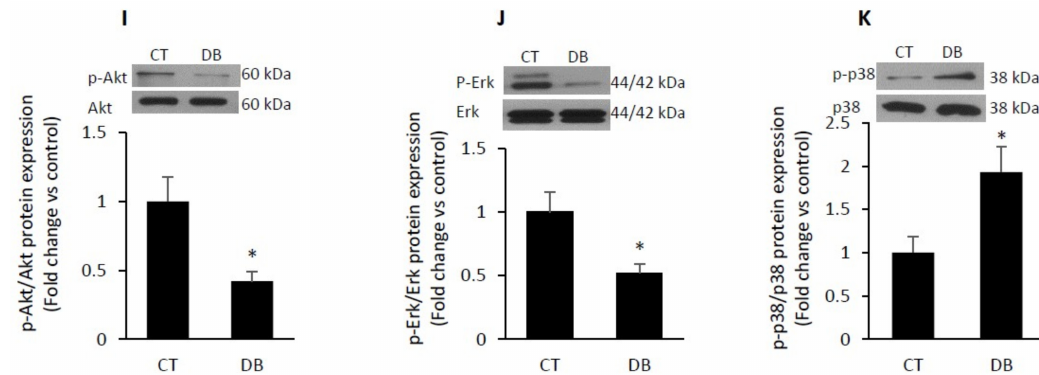
Figure 1. Diabetic W-ECs showed low proliferation rate, decreased survival and increased apoptosis. ( A ) GK rats had impaired glucose tolerance (e.g., higher AUC over 2 h) following i.p. glucose administration (2 g/kg) when compared with Wistar controls. ( B ) HOMA-IR-assessed by fasting plasma glucose and insulin levels was higher in GK rats, indicating insulin resistance. ( C ) Cell viability was determined in diabetic and control W-ECs using WST-1-based assay. ( D ) Rate of proliferation was quantified by measuring BrdU incorporation into W-ECs. ( E ) Division index of diabetic and control W-ECs was measured by CFSE dilution. ( F ) Trypan blue staining and HA-cDNA fragments ( G ) were used to detect the rate of apoptosis in both diabetic and control W-ECs. ( H – K ) Key signaling molecules involved in cell survival, p-Akt/Akt, cell proliferation, p-ERK/ERK and cell apoptosis, p-p38/p38 were quantified using a Western blotting-based technique. Abbreviations: W-ECs, wound endothelial cells; AUC, area under the curve; HOMA-IR, homeostasis model assessment of insulin resistance; WST, 4-[3-(4-Iodophenyl)-2-(4-nitrophenyl)-2H-5-tetrazolio]-1,3-benzene Disulfonate; HA-cDNA; cytoplasmic histone-associated DNA fragments; BrdU, bromodeoxyuridine; CT, control; DB, diabetic. Values are means ± SEM ( n = 6) * Significantly different from corresponding control values at p ≤